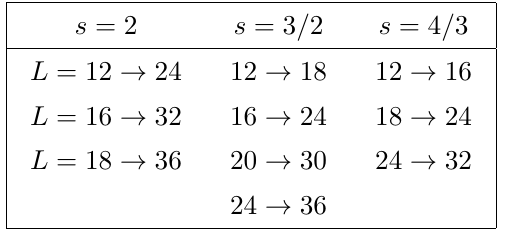
Table 1 . Pairs of lattice volumes available for the three scale changes s = 2, 3 = 2 and 4 = 3. t -shift is present we will account for it as a source of systematic uncertainty, which was not done in ref.